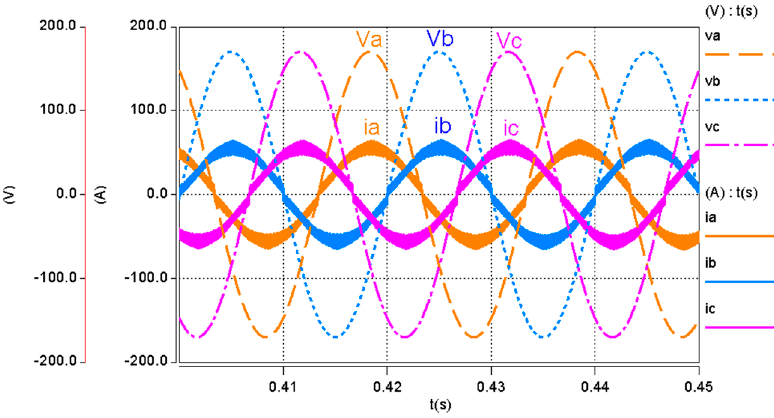
Figure 12. Input phase current and phase voltage.